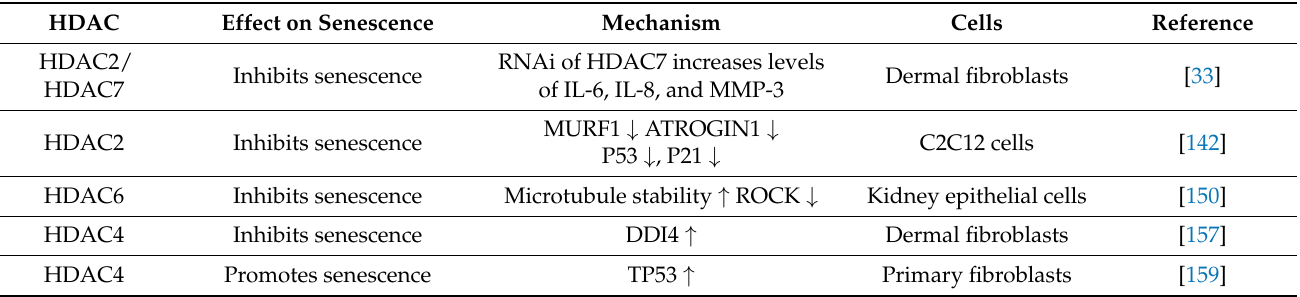
Table 2. Roles of HDACs in senescence and the